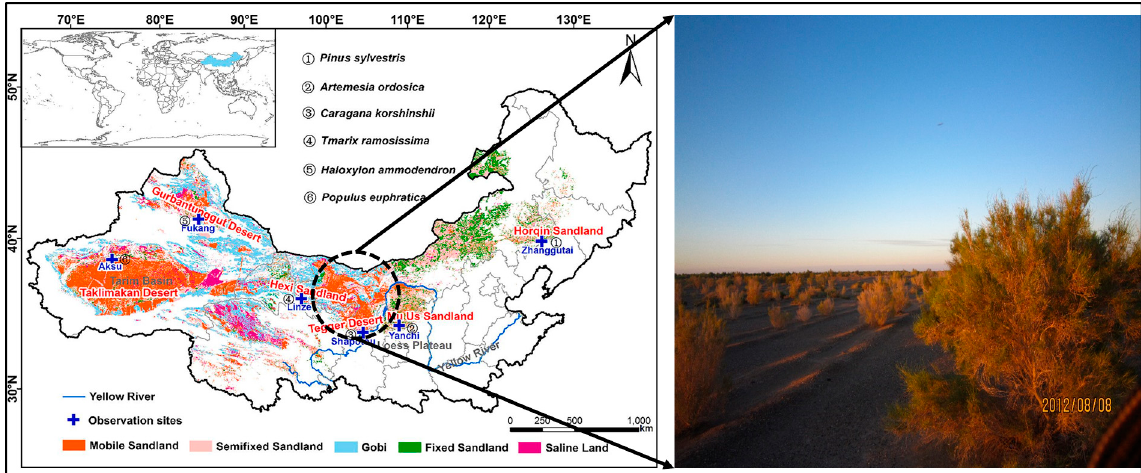
Figure 1. Location of the experimental area and research objects. The figure on the left is the distribution map of China’s deserts and sandy land; different vegetations were selected to be planted in these areas to combat desertification [32]. The experimental site is located in the transition zone of the arid desert zone to semi-arid sandy land. The picture on the right is the Tamarisk forest in Ulan Buh Desert.